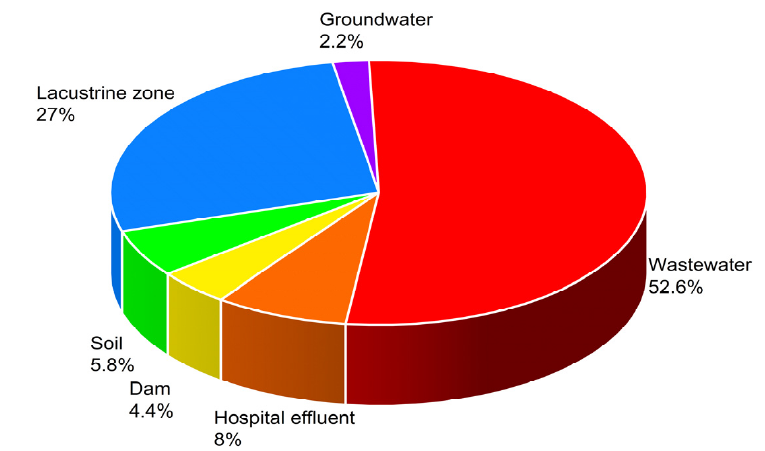
Figure 4. Distribution of water bodies with pollutants of pharmaceutical origin in Mexico City and the metropolitan area (2013–2023) [14–16,27–33].